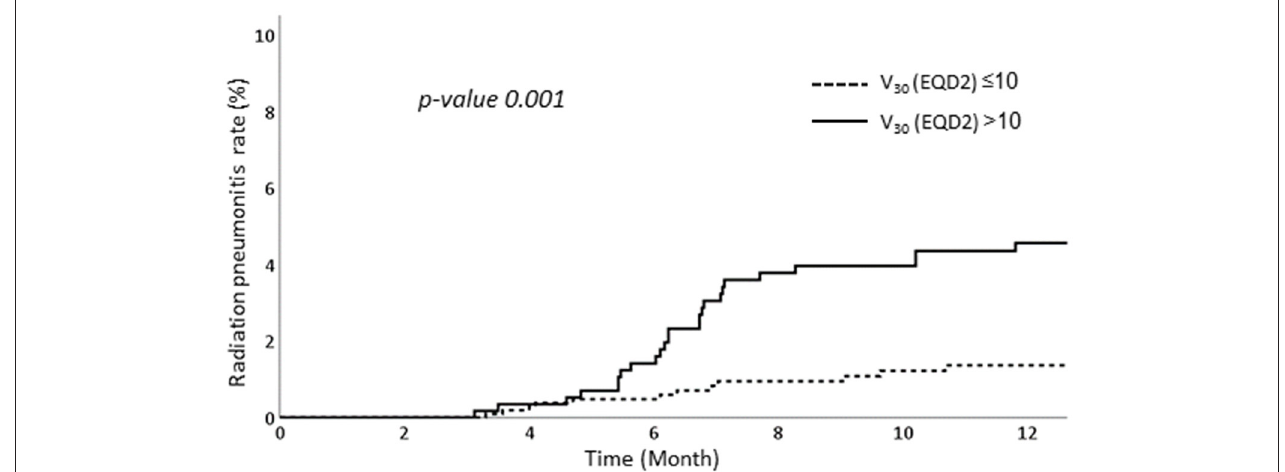
FIGURE 3 | Occurrence of radiation pneumonitis according to subgroups with V 30 > 10% and V 30 ≤ 10%.